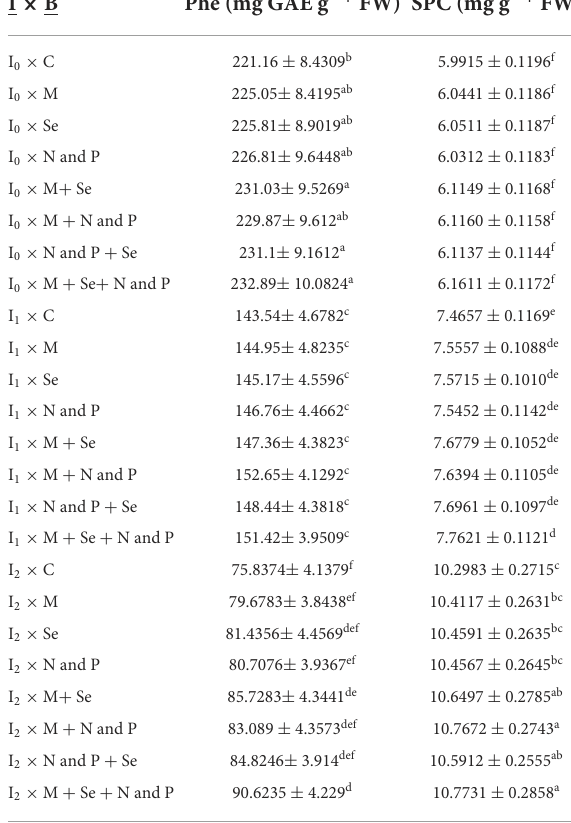
TABLE 8 Mean comparisons of the dual interactions of irrigation levels and bio-fertilizers on phenol and soluble proteins content traits in 2 years of experiment (2017–2018 and